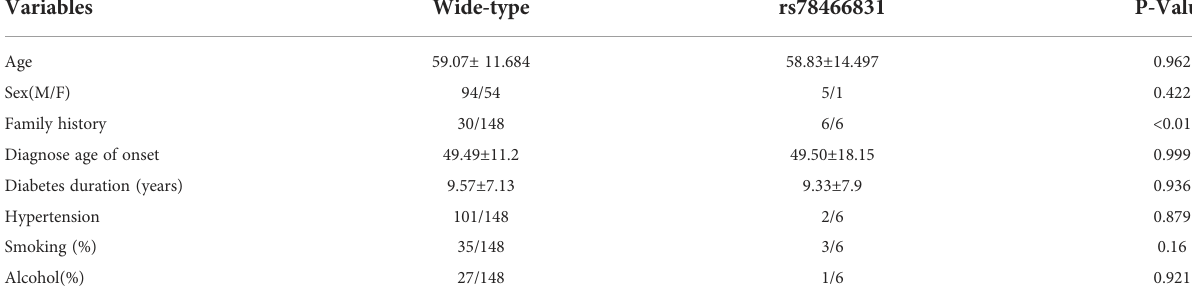
TABLE 2 General characteristics of the wild-type and rs78466831 patients with T2DM.